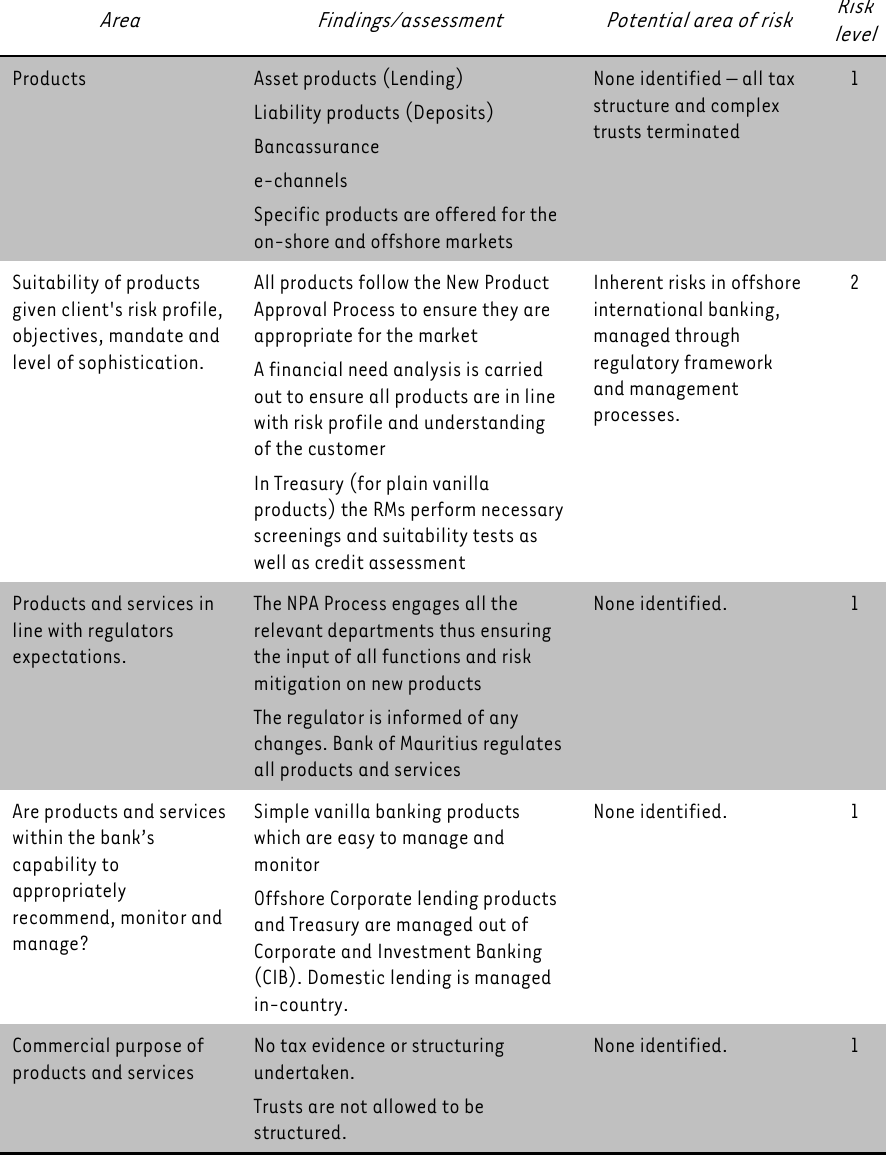
TABLE 7: Data depicted in template ‘what’ Area